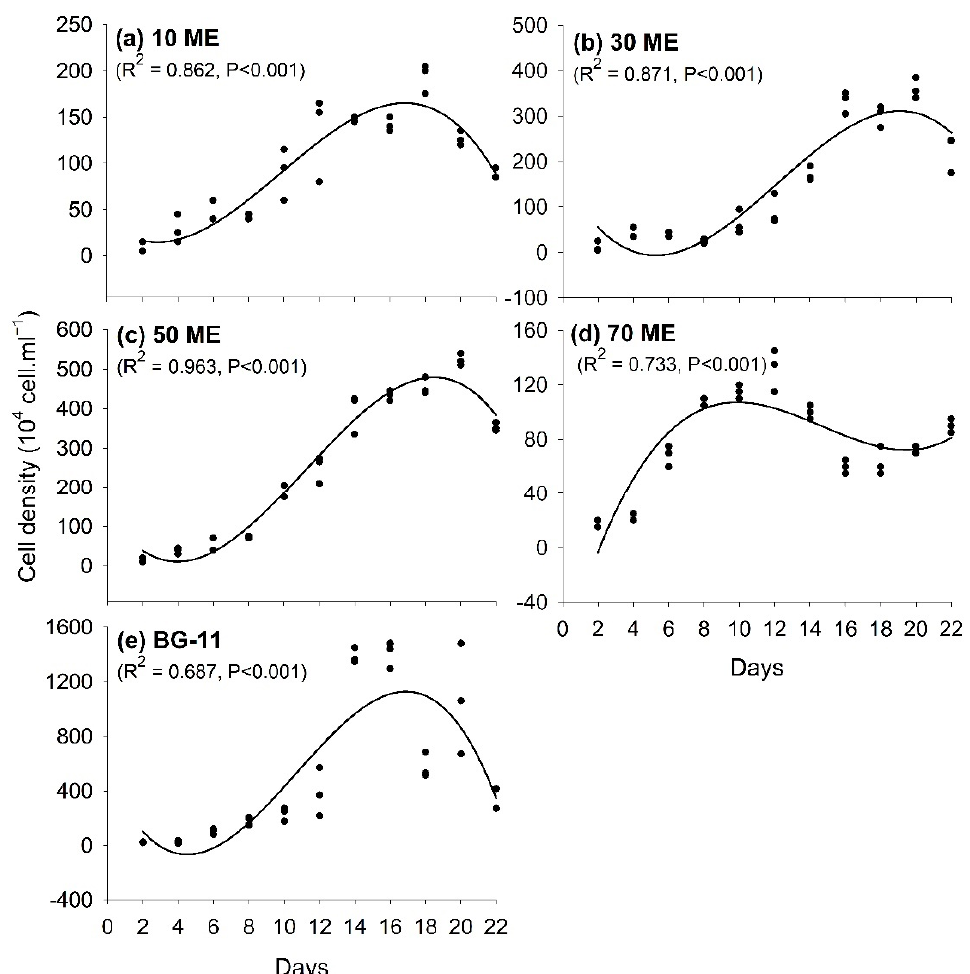
Figure 2. Variation of cell density of Chlorella sp. in ( a ) 10 ME, ( b ) 30 ME, ( c ) 50 ME, and ( d ) 70 ME of malting effluent and ( e ) BG-11 standard mineral media during 22 days of cultivation time. The regression lines are derived from polynomial third ‐ order regression.